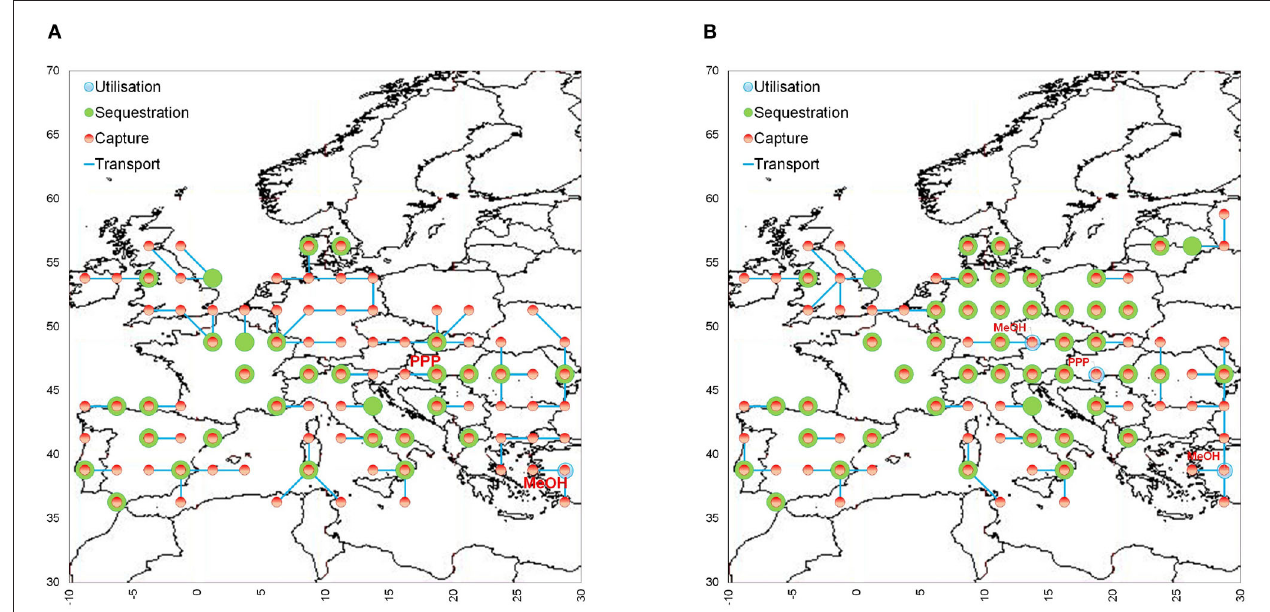
FIGURE 5 | Final SC configurations for (A) Scenario B and (B) Scenario